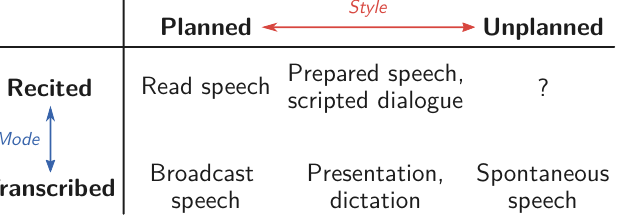
Figure 1. A finer categorization of ASR data by speech production styles and data acquisition modes, with exemplary instances. The conventional terms “read speech” and “spontaneous speech” constitute opposing poles. The style axis is a continuum: “semi-planned” situations, as in dictation or some news speech, are possible. It is unclear whether completely unplanned recited speech (marked with “?”) is possible at all (perhaps the oral performance of certain stream-of-consciousness texts would come